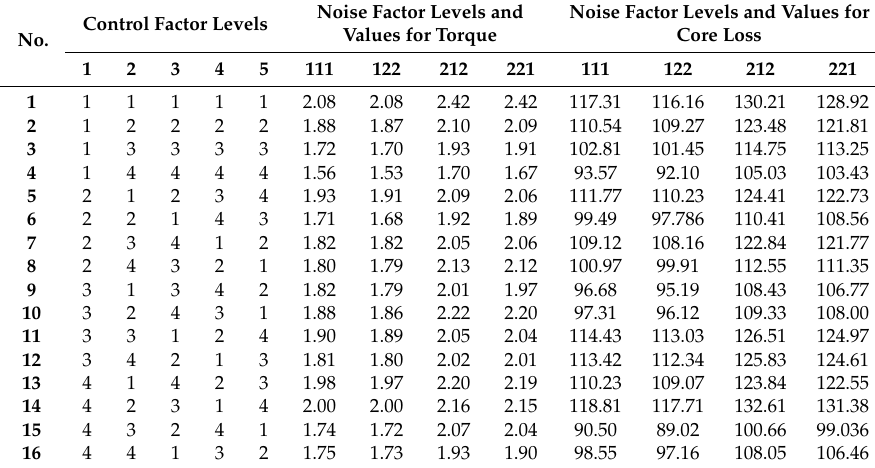
Table 8. An orthogonal array for the output torques and core losses of the